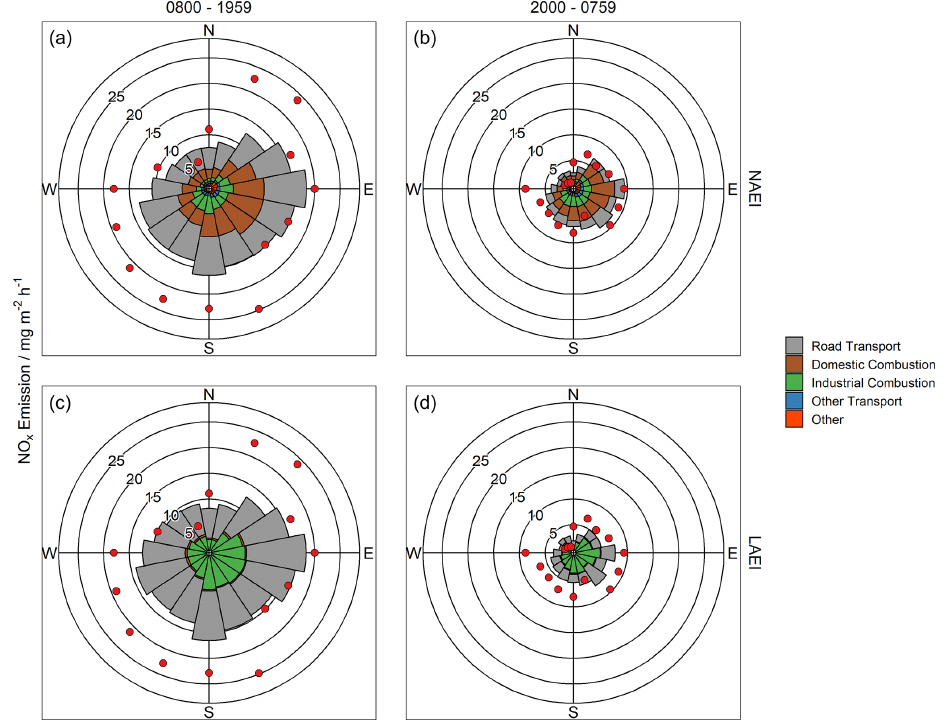
Figure 11. NO x emissions (red) measured at the BT Tower in March–July 2017 and the NAEI’s estimated emission (bars) from within the flux footprint, averaged by 22.5 ◦ wind sector bins. NAEI emissions are coloured by source sector contribution. The left-hand panel shows all data between 08:00 and 19:59, and the right-hand panel shows all data between 20:00 and